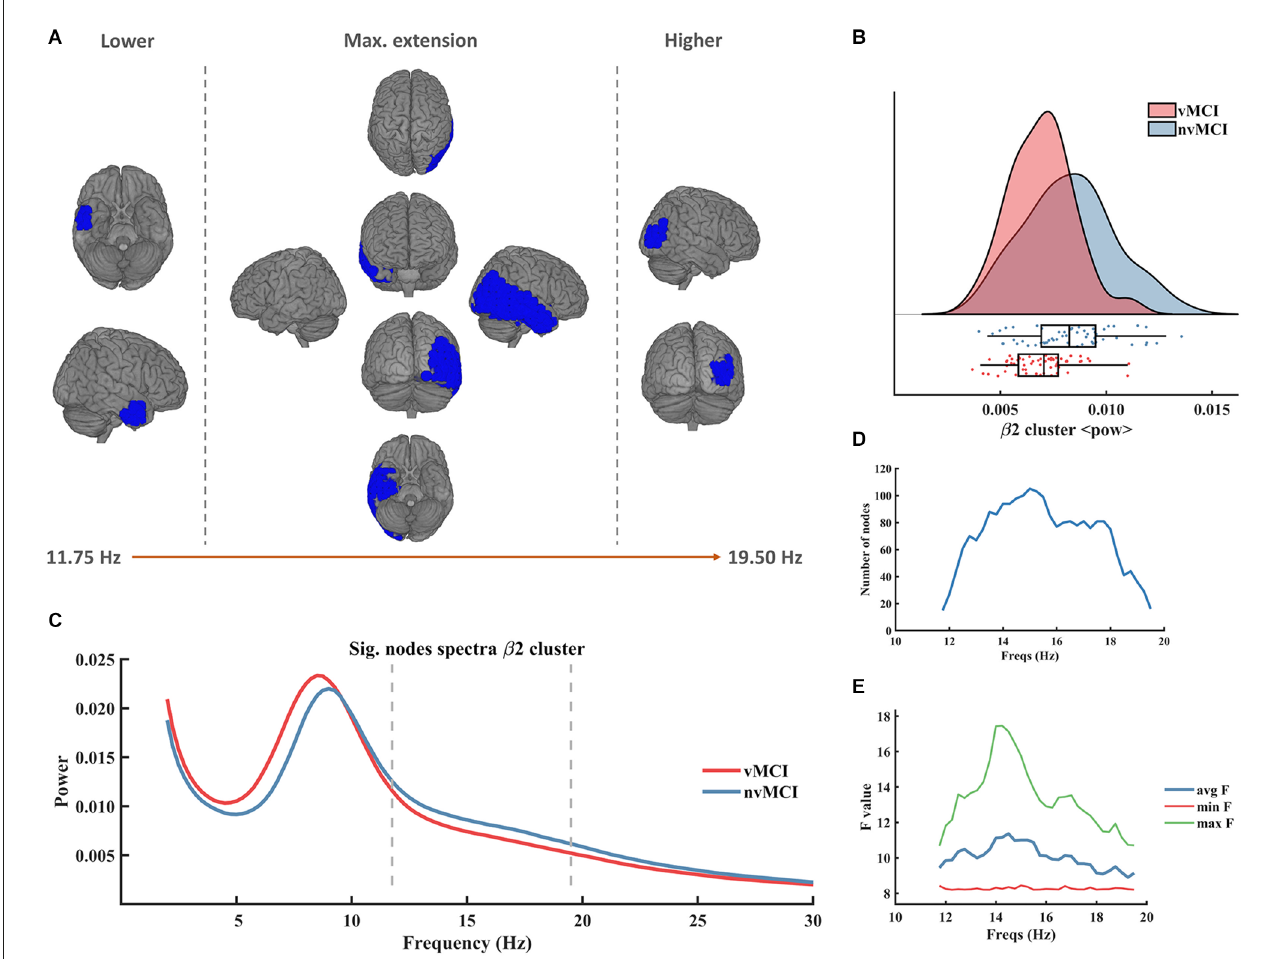
FIGURE3 Significant result found within the beta frequency range in the right temporo-parietal region. (A) Description of the regions involved in the β 2 cluster. The cluster was found to be significant between 11.75 Hz and 19.50 Hz. In the figure can be seen the initial, final, and maximum extensions of the cluster. (B) Violin plots and boxplots graphics describing the individual values for the average power of the cluster in the significant frequency range. (C) Representation of the average spectral power across all significant nodes. The significant frequency region is marked with dashes lines. (D) Number of grid nodes that are part of the cluster at each frequency step (maximum extension was found at 15 Hz). (E) Minimum, maximum, and average F values across all nodes contained within the cluster at each frequency step.